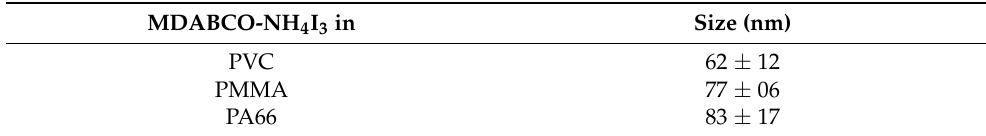
Table 1. The average crystallite size of MDABCO-NH 4 I 3 perovskite crystals embedded in electrospun fibers.